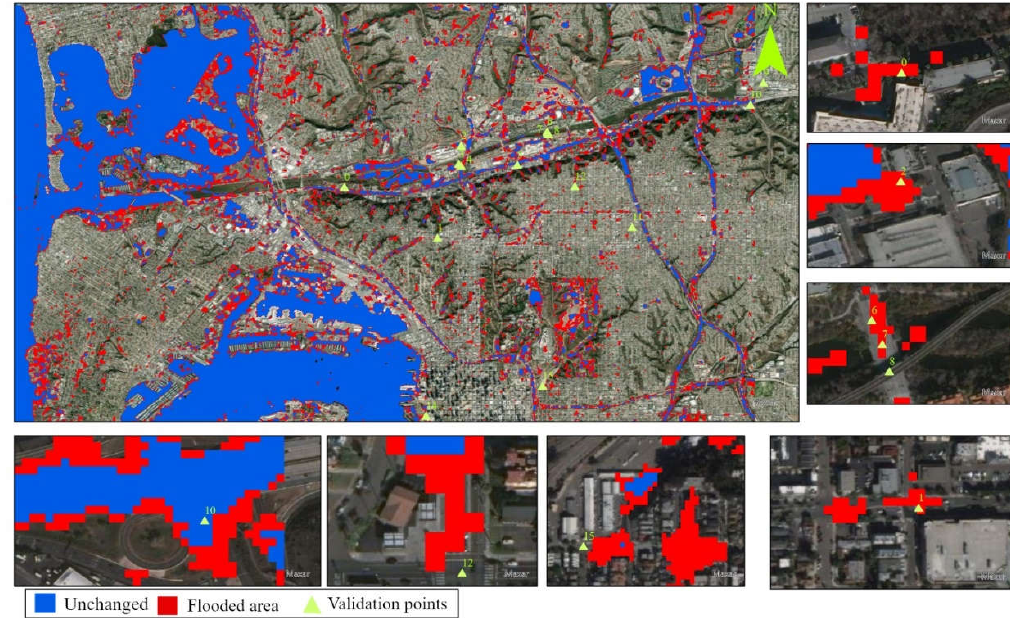
Figure 8. 2018 Flood scenario obtained from the change detection method.